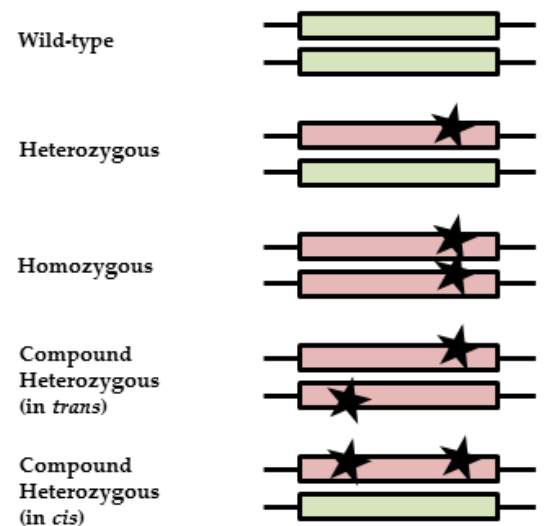
Figure 1. Illustration of zygosity and clinical interpretations. Black stars represent variants; boxes represent alleles. A wild-type patient carries no variants, resulting in normal-activity alleles (green). A heterozygous patient carries one variant, resulting in one reduced or inactive allele (red) and one active allele (green). A partly reduced enzyme activity is expected, since there is still one active allele left. For homozygous patients, both variants result in a reduced or inactive allele (red). Depending on the effect of the variants on the protein, a reduced or absent enzyme activity is expected. Compound heterozygous patients can carry variants on different alleles (in trans ) or on one allele (in cis ), resulting in differences in enzyme function, either like that of a heterozygous patient or a homozygous patient.